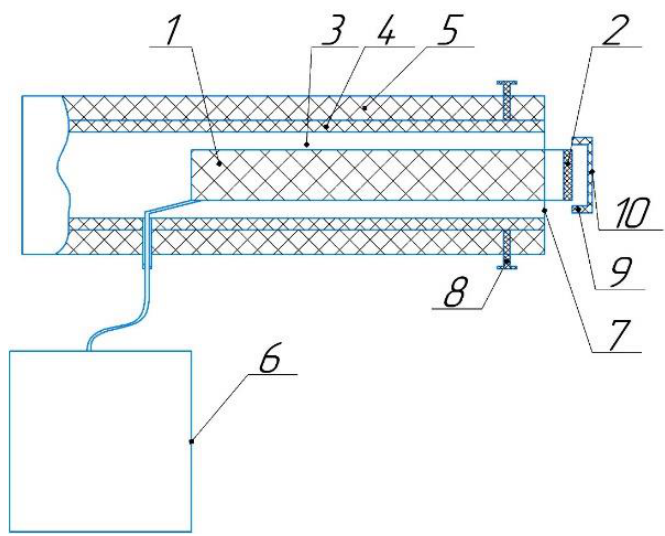
Figure 1. Scheme of the CAP generator output device: 1 — piezo transformer; 2 — discharge electrode; 3 — ionization chamber; 4 — dielectric tube; 5 — hard case; 6 — voltage generator; 7 — output end of the dielectric tube; 8 — device for changing the shape of the output end of the tube; 9 — dielectric cap; 10 — dielectric layer.